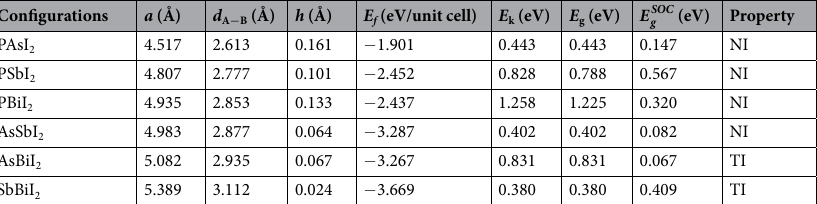
Table 1. Calculated lattice constant ( a ), bond length ( d A − B ), buckled height ( h ), formation energy ( E f ) and material property of ABI 2 monolayers. E k and E g represent the band gap opening at K point and global band gap excluding SOC, respectively. E gSOC denotes the SOC-induced band